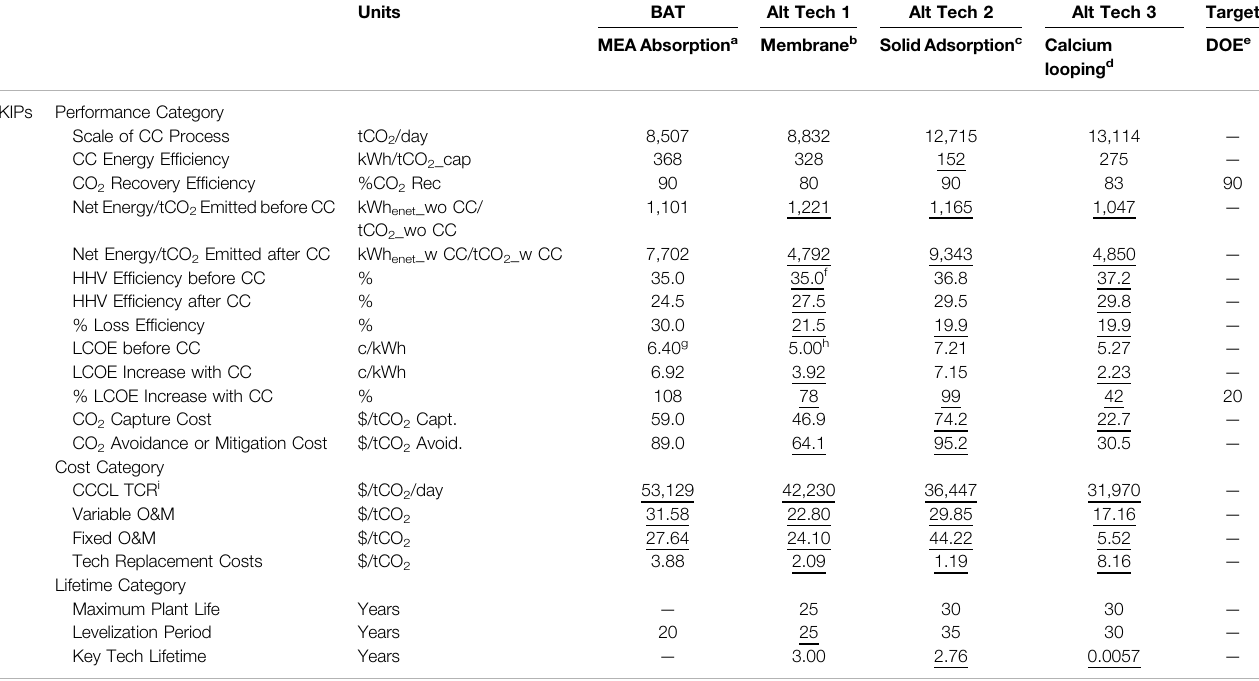
TABLE 4 | TDM KIPs for the selected MEA scrubbing (BAT) and three post-combustion CCTs as user ’ s Alt Techs of this